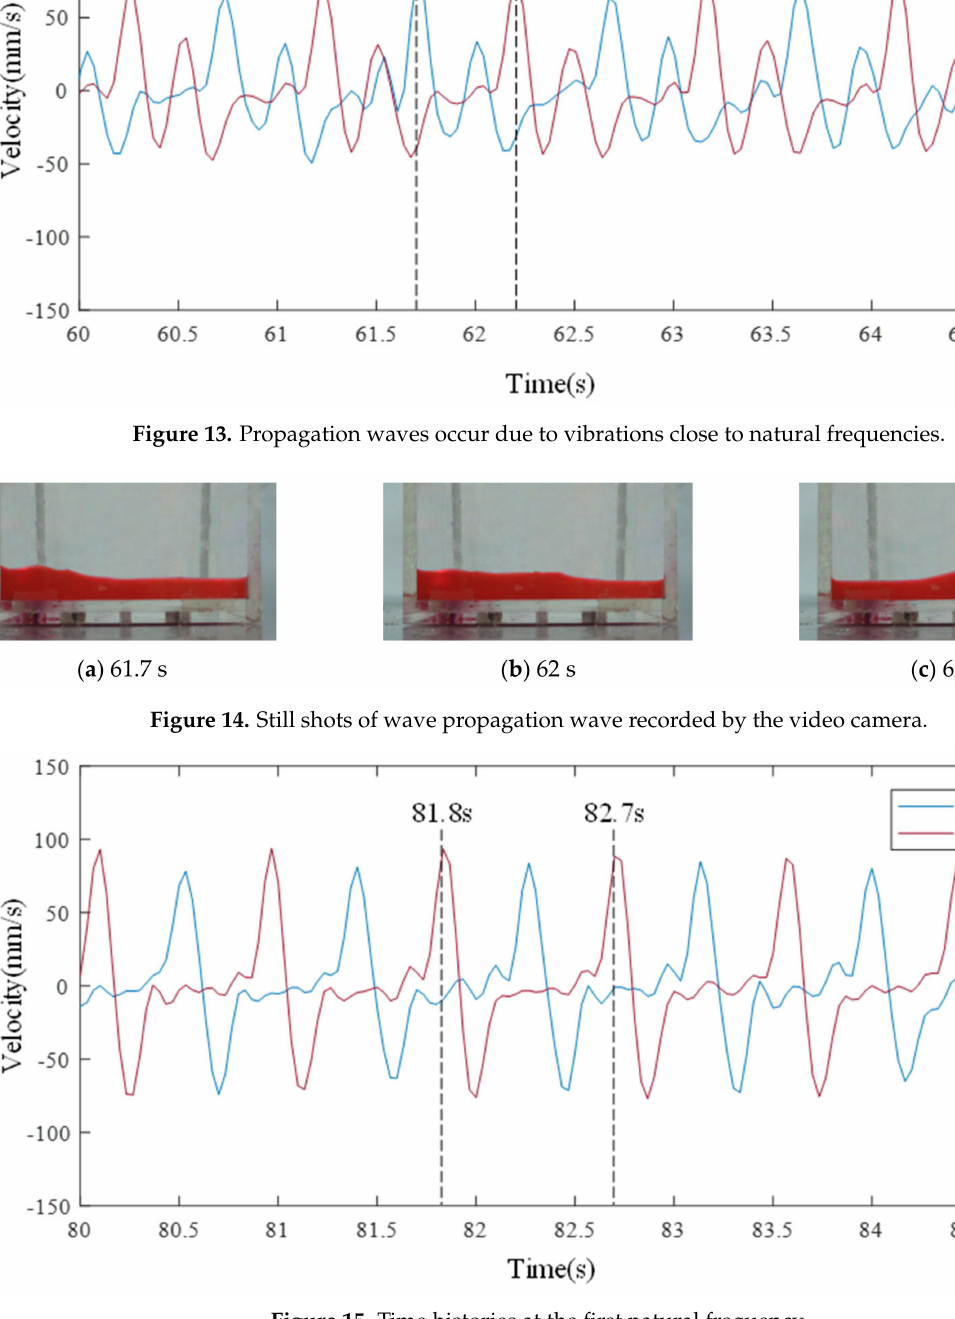
Figure 15. Time histories at the first natural